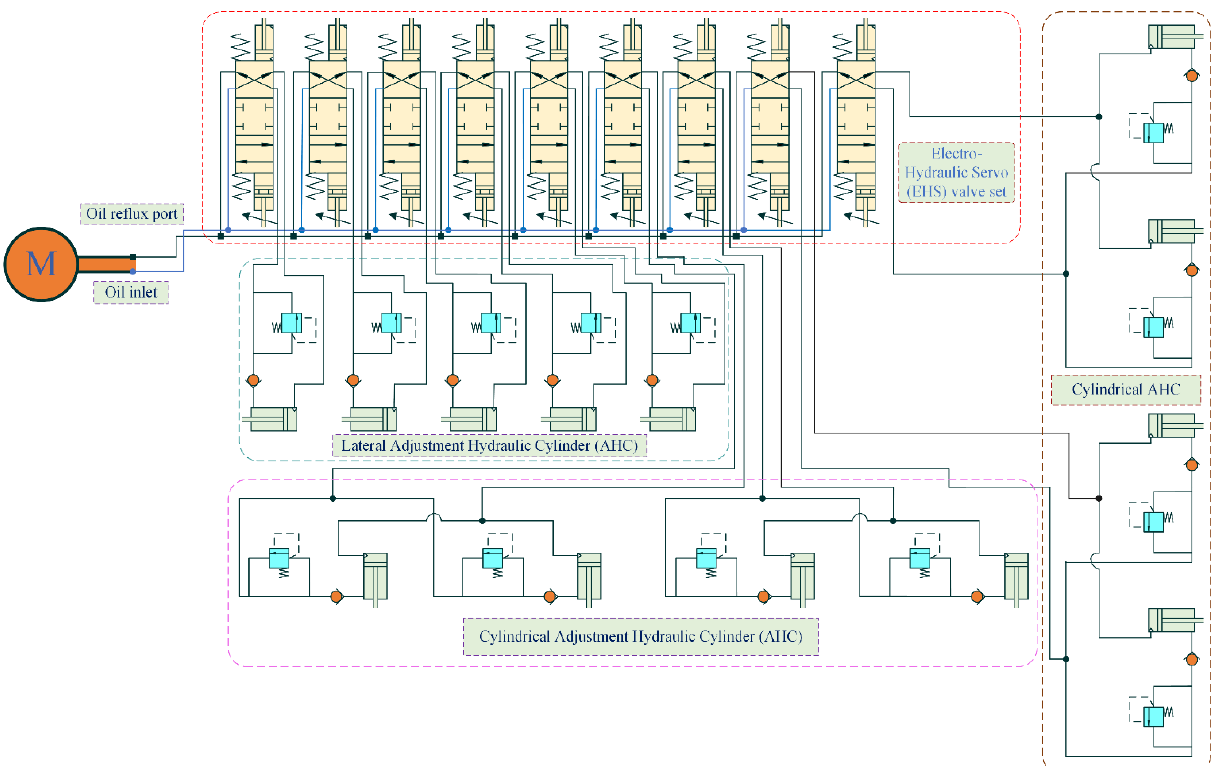
Figure 5. A model of the hydraulic system with AHC for ESR.